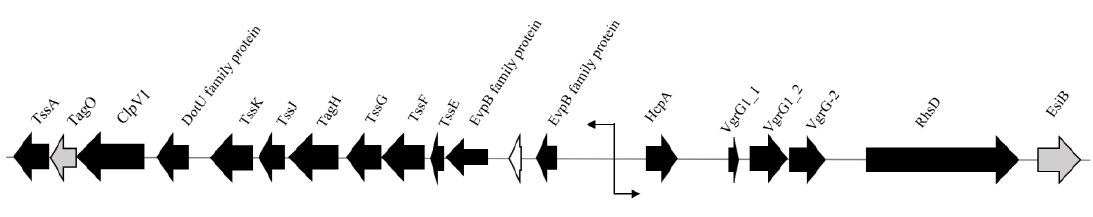
Figure 2. Schematic representation of the T6SS gene cluster in S. Agona FSL S5-517. Arrows indicate direction of transcription. Black arrows indicate gene products involved in the T6SS. Grey arrows represent gene products of unknown function but believed to play a role in the T6SS. White arrow indicates a hypothetical protein.